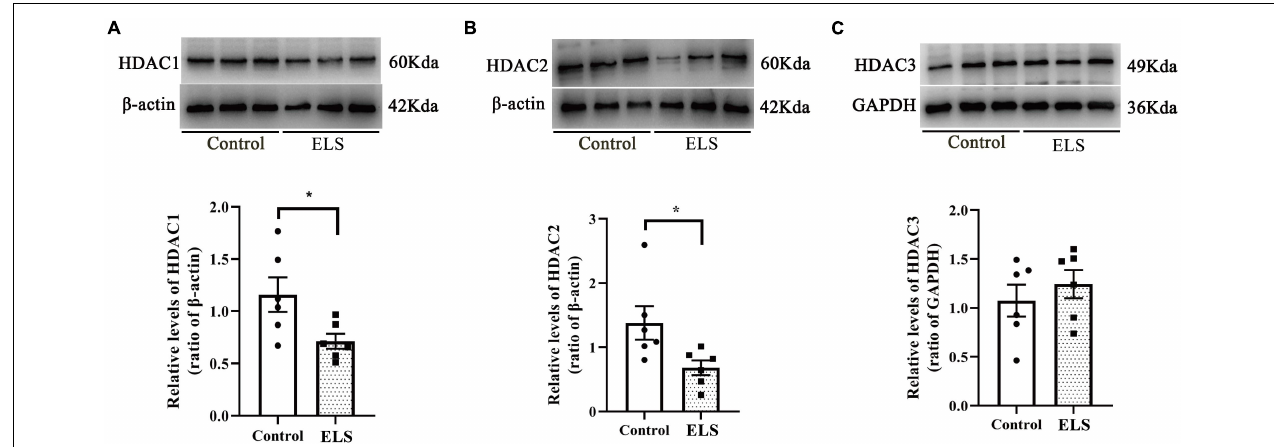
FIGURE 4 | The expression of HDAC1, HDAC2 and HDAC3 in the amygdala nucleus of rats. Western blot showed that the expression of HDAC1 (A) and HDAC2 (B) in the amygdala nucleus decreased significantly while HDAC3 (C) expression showed no significant difference in ELS rats compared to control rats * p < 0.05. N = 6. Independent samples t -test was performed (A–C) . N represents the number of rats per